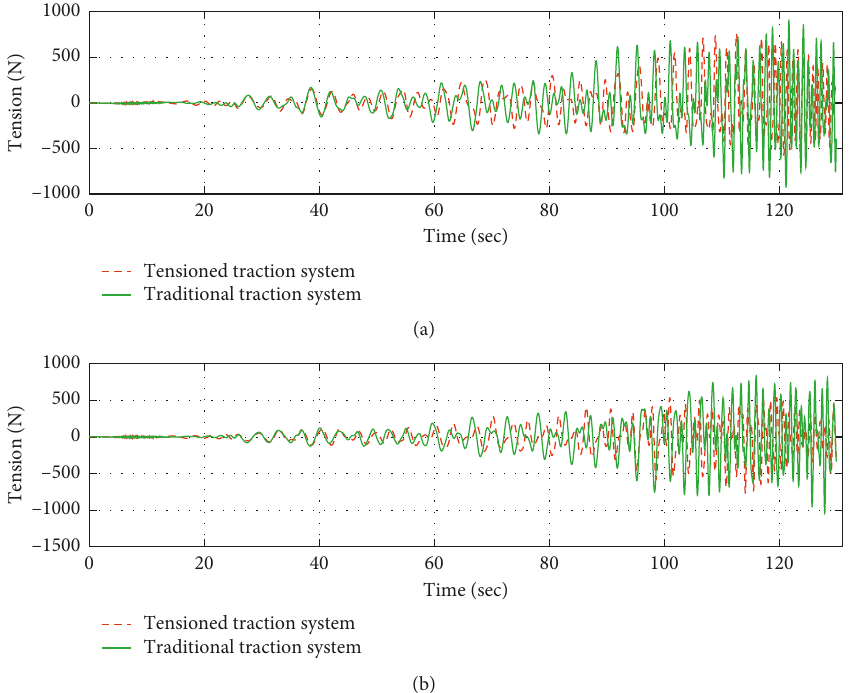
Figure 30: Comparison of the transverse connecting forces in a tensioned traction system and traditional traction system; (a) connecting ; (b) connecting point C . point C 1 2